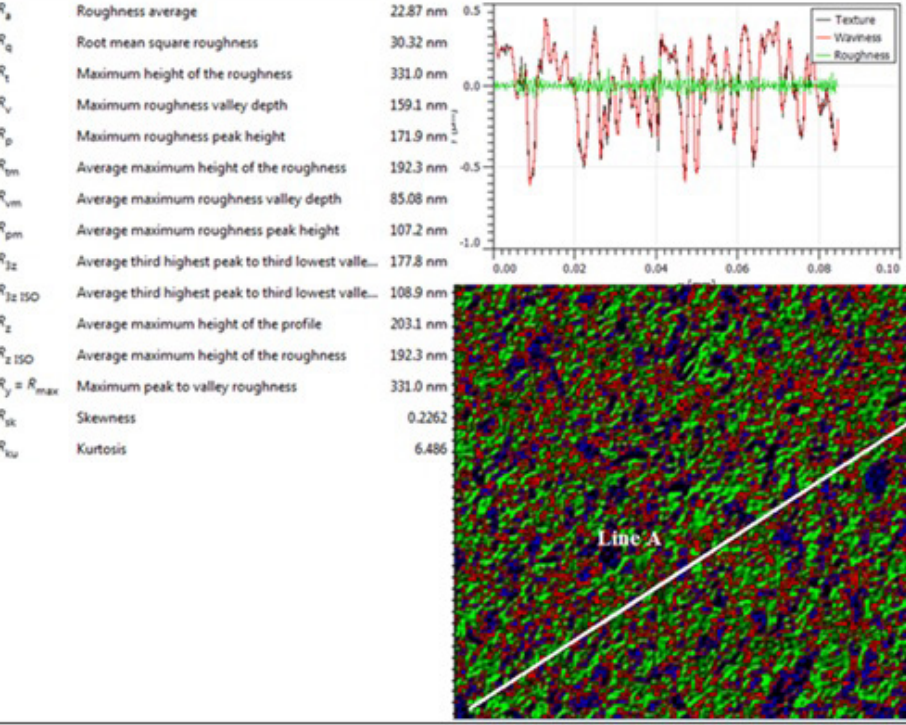
Figure 9. Surface parameters of Nitinol composite at 1000 0 C for 5 minutes.